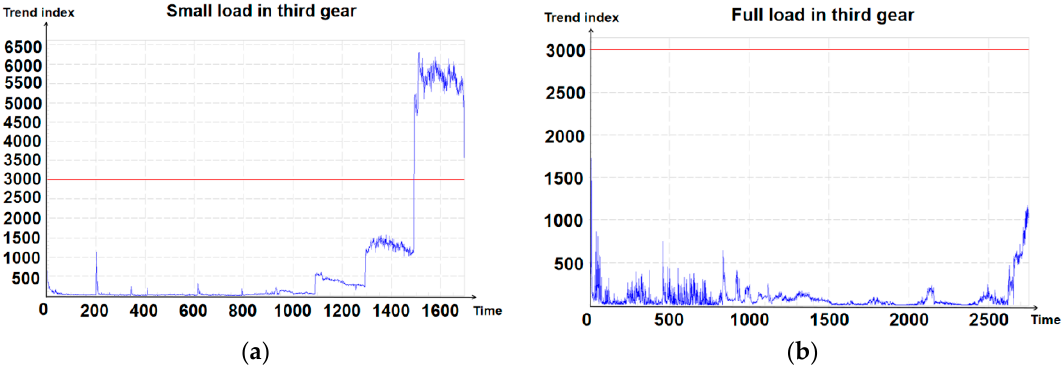
Figure 9. Small load ( a ) and full load ( b ) in third gear.